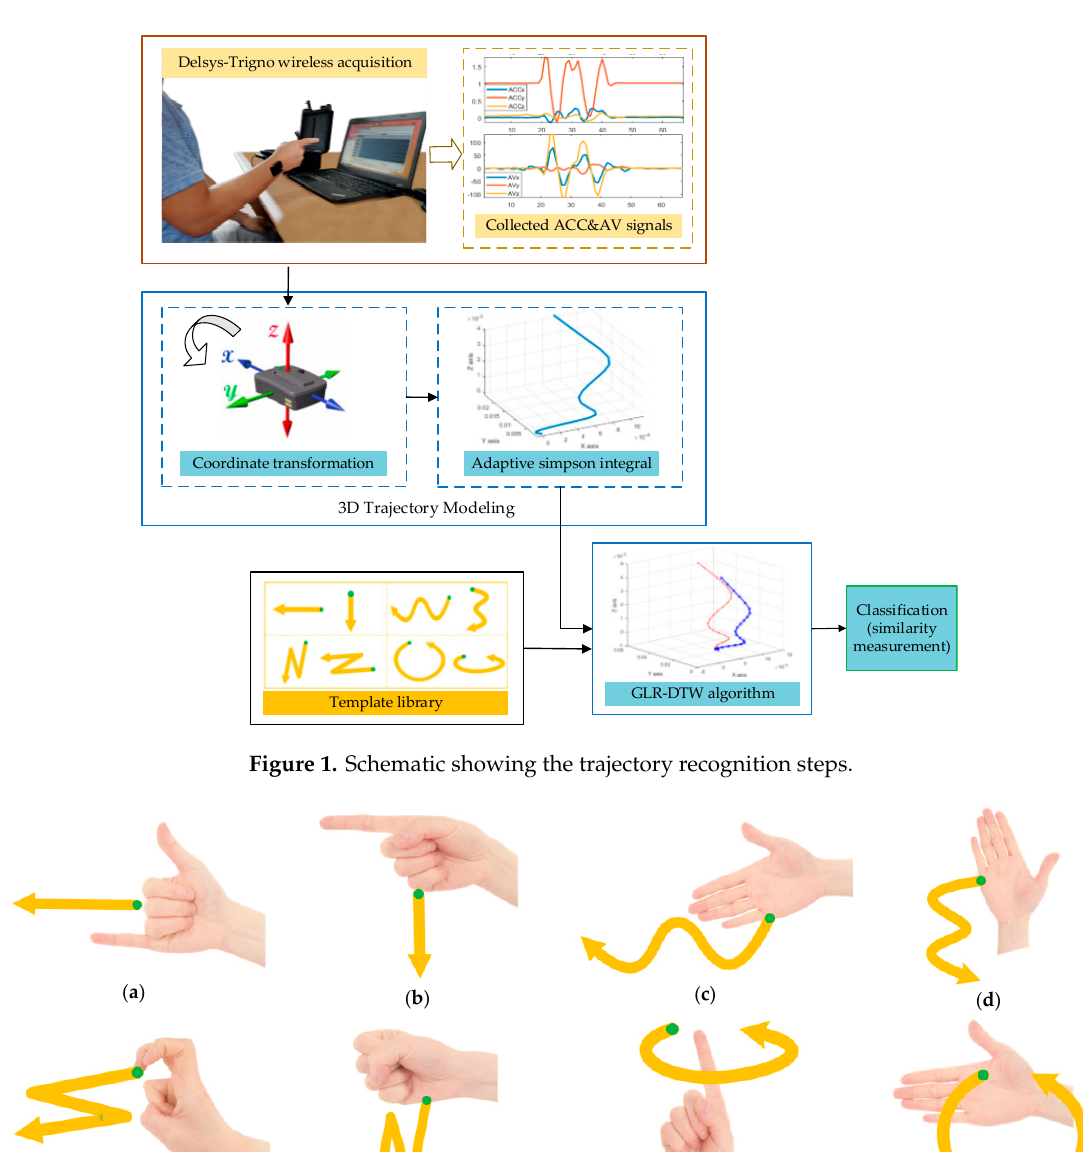
Figure 2. Schematic diagram of eight kinds of sign language (SL) movement trajectories. (a) Horizontal straight-line movement; (b) Vertical straight-line movement; (c) Horizontal wave-shape movement; (d) Vertical wave-shape movement; (e) Horizontal shaking; (f) Vertical shaking; (g) Horizontal circular arc movement; (h) Vertical circular arc movement. Table 1. Description of eight kinds of trajectory and corresponding vocabulary.